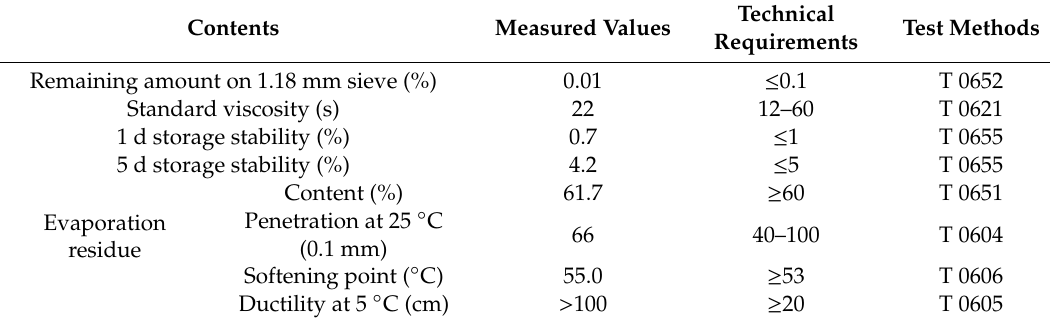
Table 1. Technical properties of the styrene–butadiene rubber modified asphalt emulsion (SBRAE).